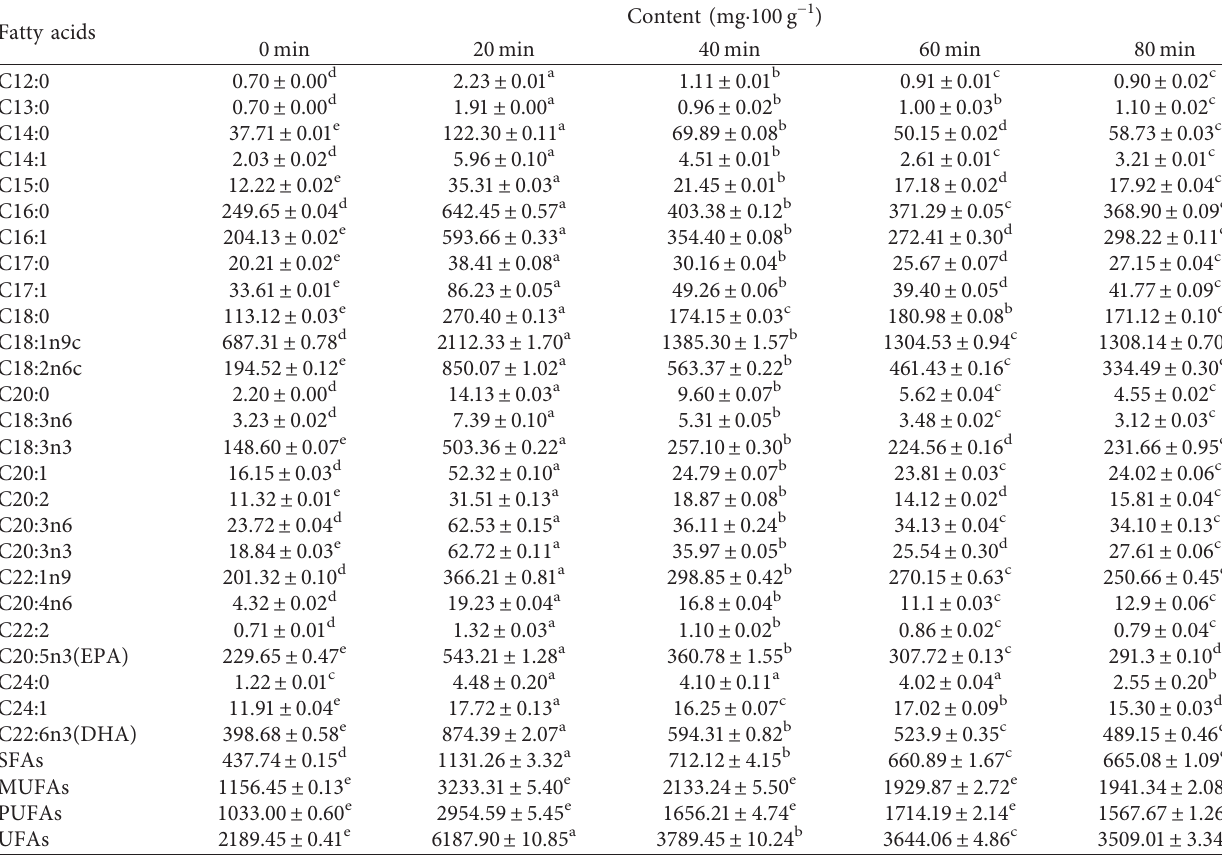
Table 2: Fatty acid profiles of giant salamander jerkies as affected by roasting